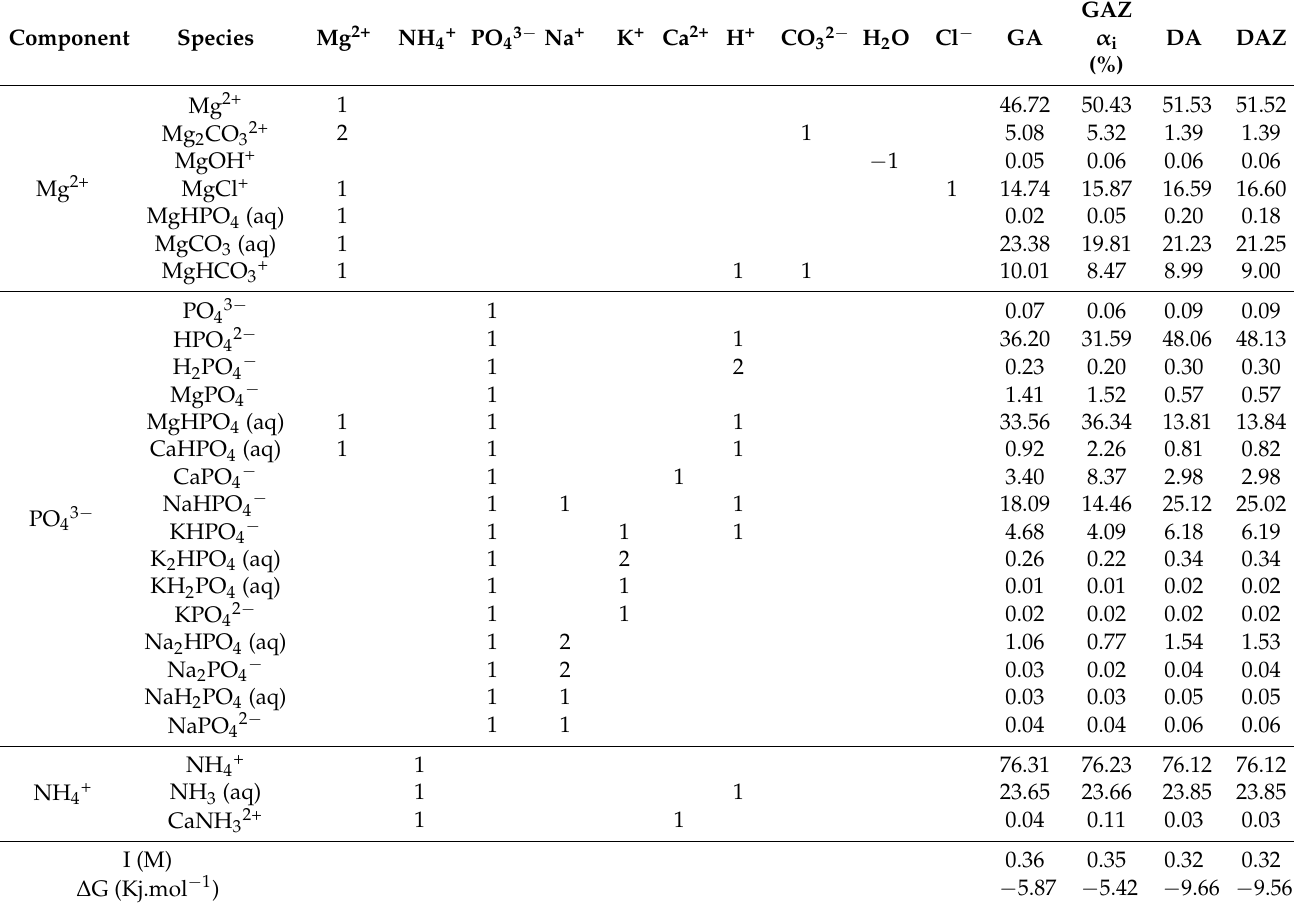
The ∆ G . in Table 4 highlights the enhanced trend to equilibrium energy ( ∆ G = 0) due to the addition of zeolite. The positive effect is found on the final ammonium concentration in the effluent, as described in Section 3.2. This is an advantage in the mitigation of the en- vironment pollution caused by the excessive ammonium in struvite precipitation effluent. Table 4. Stoichiometric matrix of the struvite components and species molar fractions at equilibrium of different experiments.